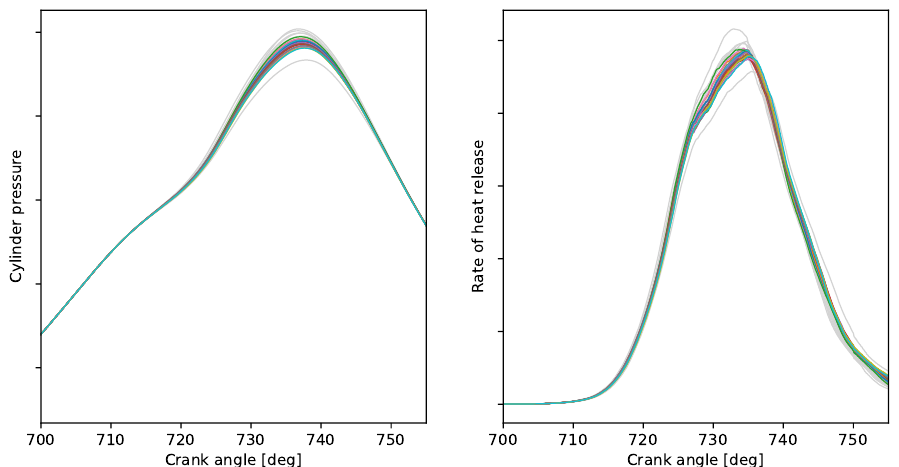
Figure 12. In-cylinder combustion process results of the common multicycle simulation and 20 artificially generated initialization